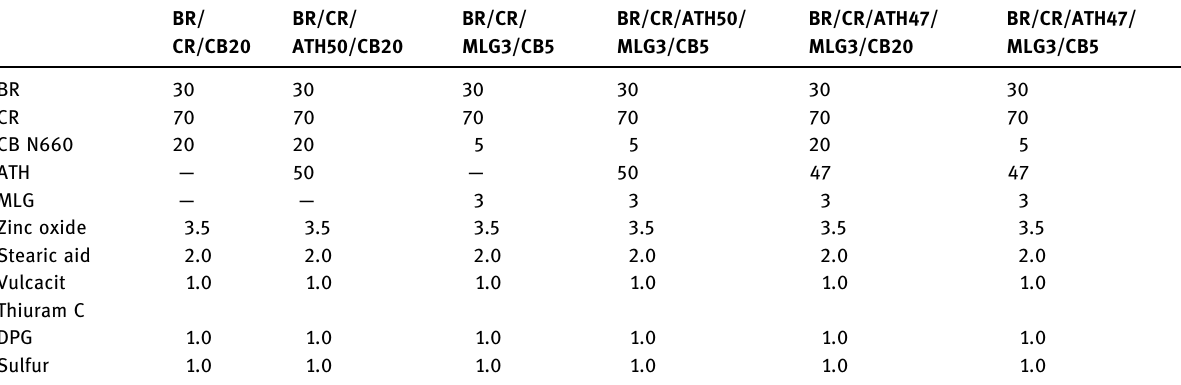
Table 1: Rubber compound formulations, given in per hundred rubber ( phr )